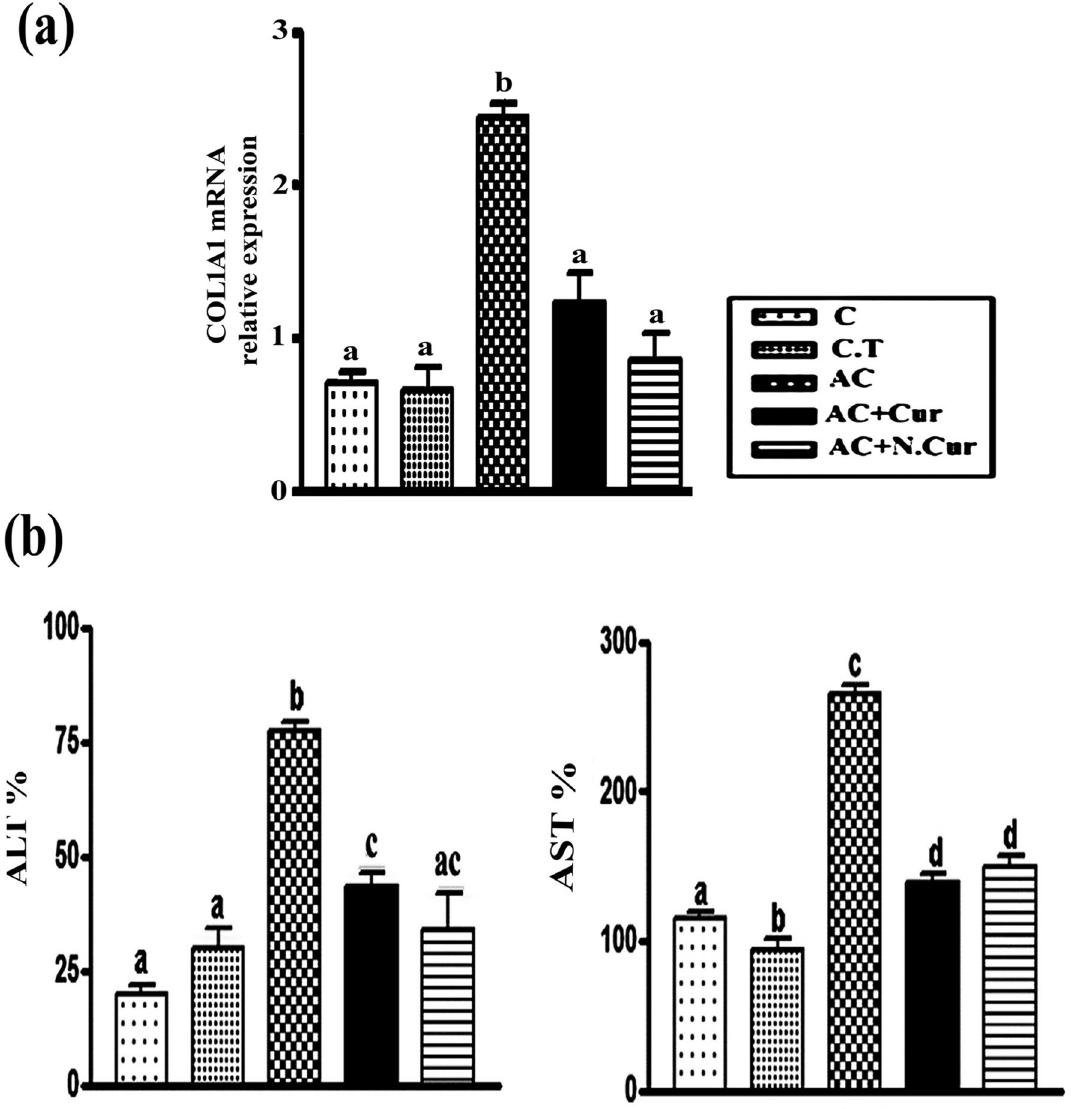
Figure 7. (a) COL1A1 expression levels (mean ± SEM). (b) AST and ALT levels in male mice. Values in the same column with unlike superscript letters are significantly different at p <